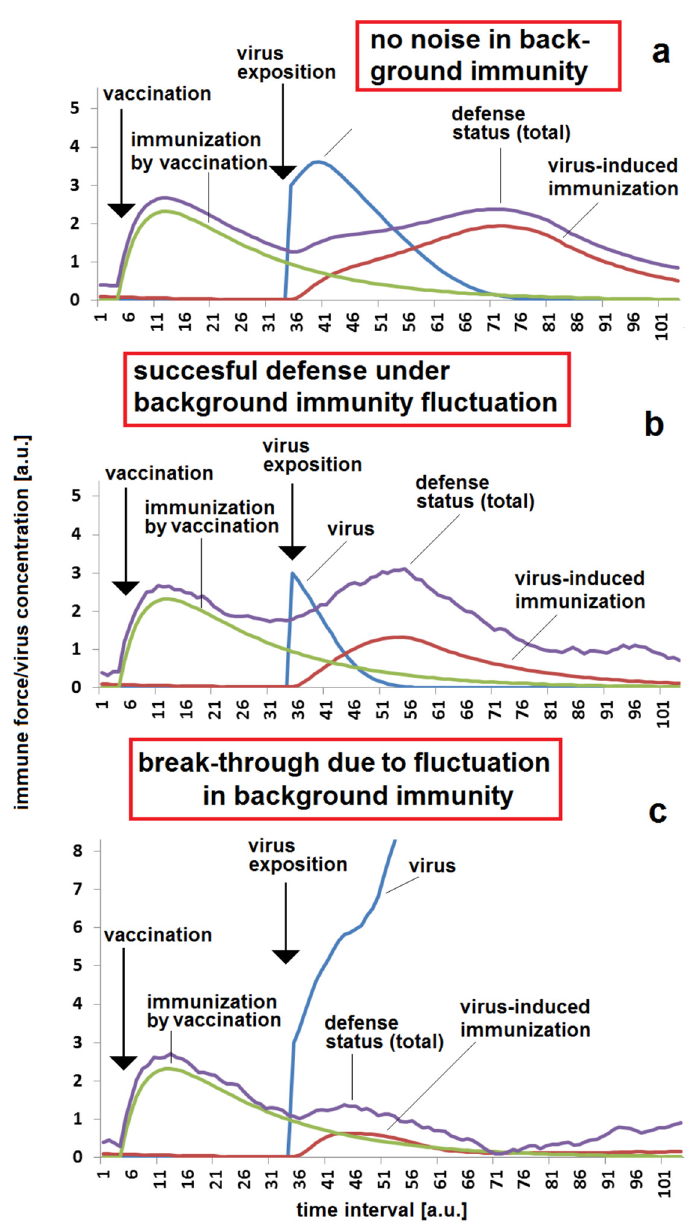
Figure 9. Effect of fluctuations in unspecific background immunity with different amplitudes: ( a ) sufficient protection for a certain time after vaccination in the case of very low or no fluctuations in background immunity, noise = 0; ( b ) successful defense against infection in the case of a higher fluctuation amplitude, but with a virus exposition in a phase of high unspecific background immunity; ( c ) breakthrough infection in the case of a higher fluctuation amplitude, but with a virus exposition in a critical phase of low unspecific background immunity. ( b , c ) have the same noise = 0.2 and the same set of other parameters were used for all simulations ( a – c ): k vir = 0.3; k r = 0.12; k st = 0.07; D AB = 0.05; Dvacc = 0.4; c BGim = 0.3; v oo = 30; st oo = 10.